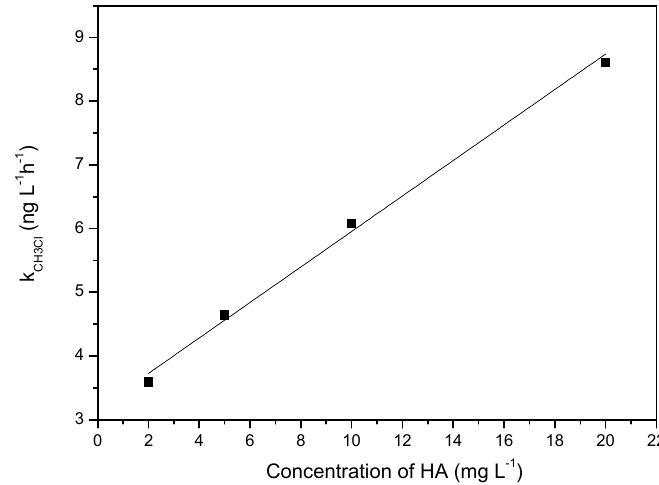
Figure 3. E ff ect of concentration of HA on the rate constant (k) of CH 3 Cl formation after correction for the light shielding e ff ect. Straight line is the trend line of linear fitting of k CH3Cl and HA concentration. Reaction conditions: [Cl − ] = 0.5 mol L − 1 , t = 10 h, pH = 6.5.